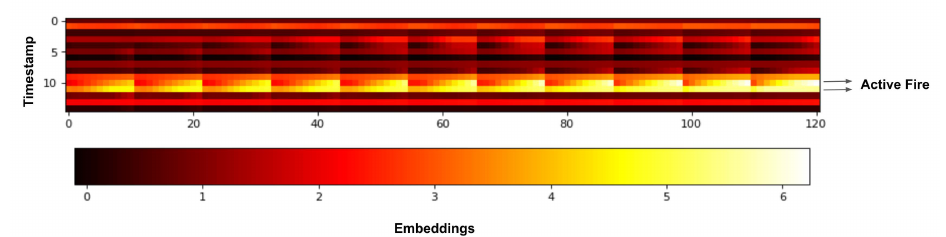
Figure 7. Time-series of embedding, x -axis represents the embedded vector for each pixel and its neighborhood pixels and its corresponding label at the last column, y -axis represents the timestamps. The figure shows the embedding for the first 20 timestamps for one image